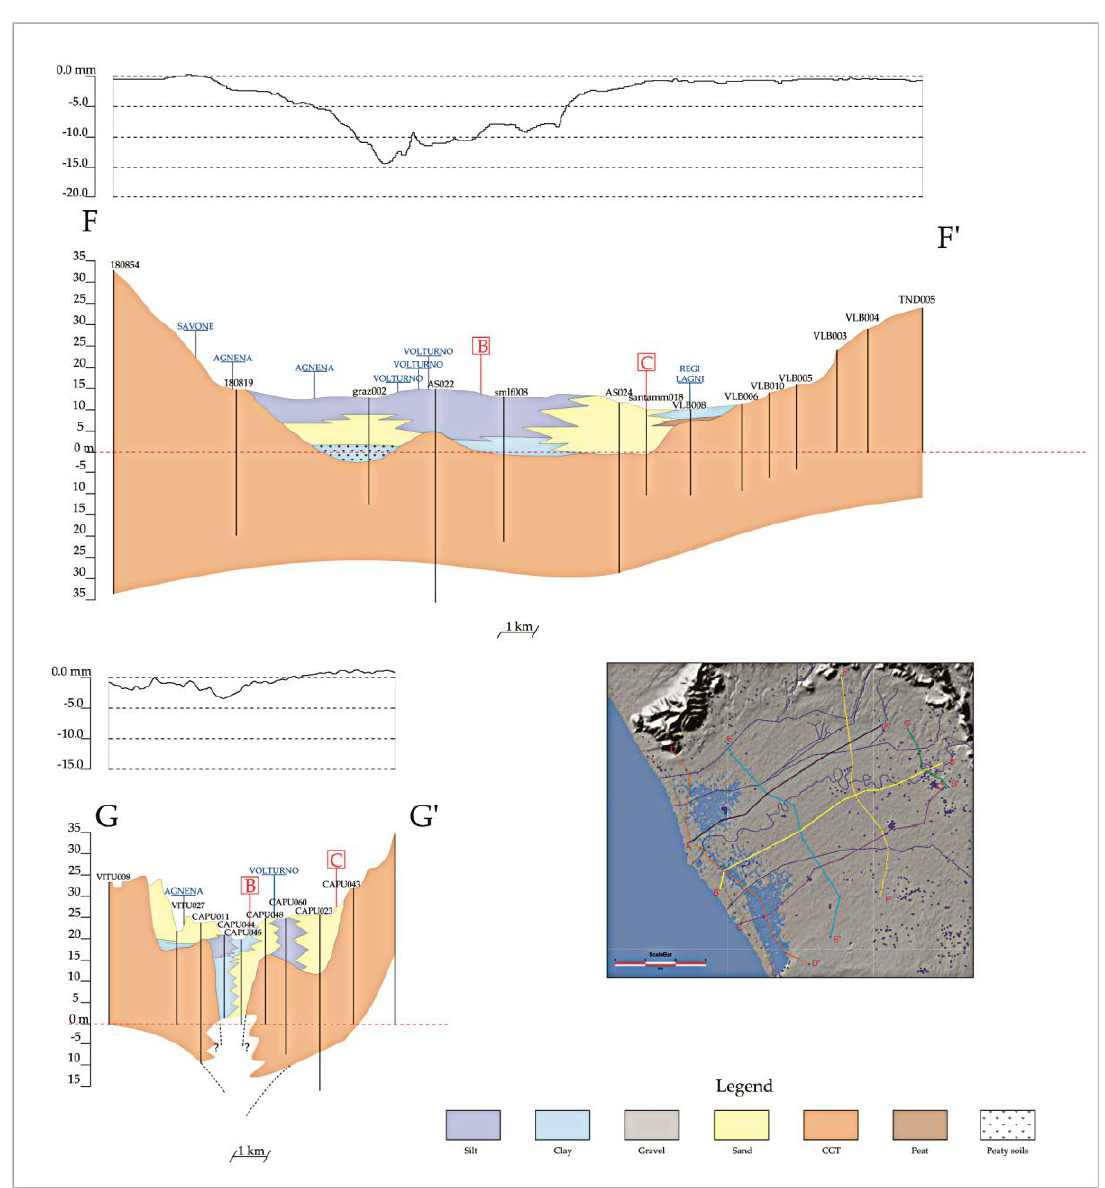
Figure 5. Deep ( A - A’ , B - B’ , C - C’) and strike ( D - D’ , E - E’ , F - F’ , G - G’ ) geological cross-sections with subsidence profile during 1992–2010 time span (in mm). Red labels refer to the intersection of the geological profiles; in blue the hydrography.